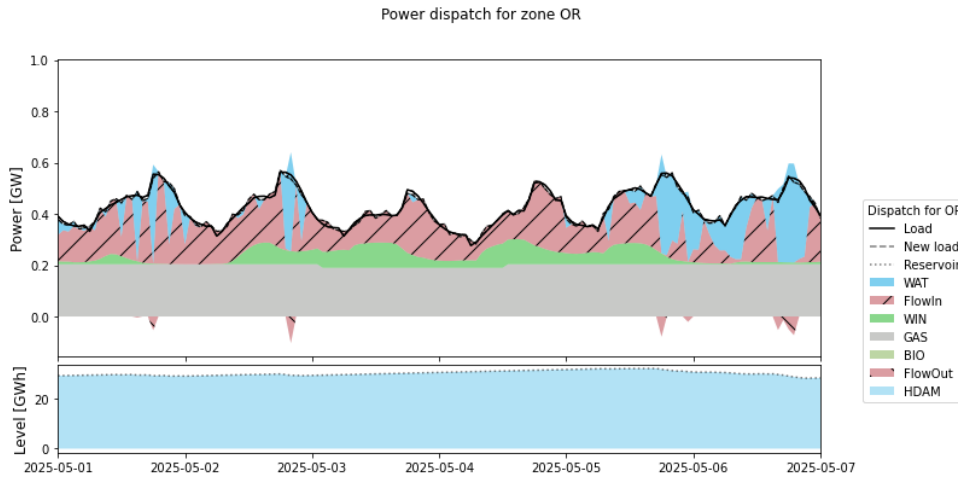
Figure 19. Low0Penetration Scenario 1(H)—North zone (1–7 May 2025).